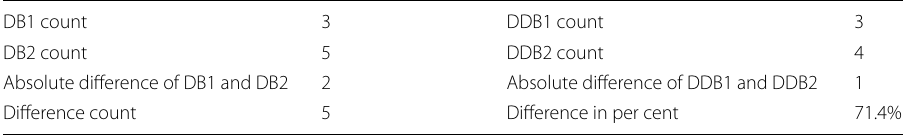
Table 3 Row validation statistics—“Users" table DB1